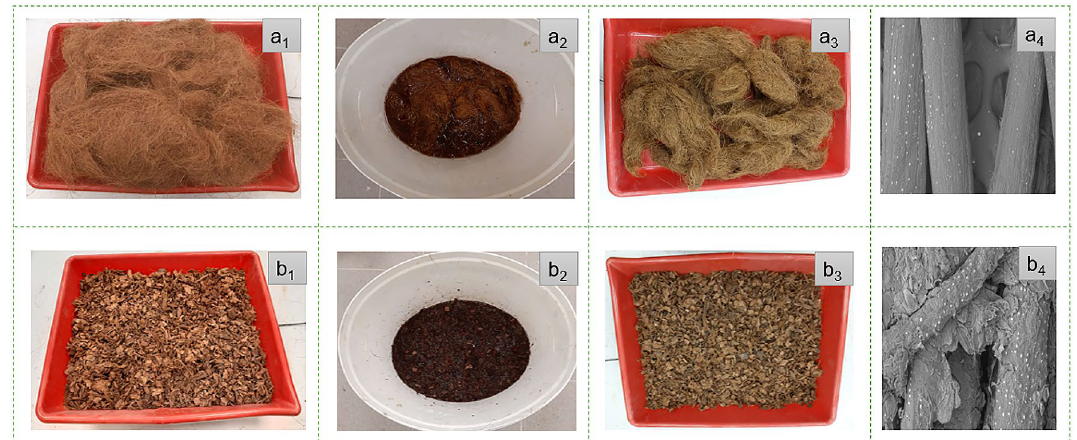
Figure 1. Photographs of coir fibers: (a 1 and b 1 ) before pretreatment; (a 2 and b 2 ) coir fibers in alkaline solutions; (a 3 and b 3 ) coir fibers after treatment; (a 4 and b 4 ) morphological views of coir fibers .